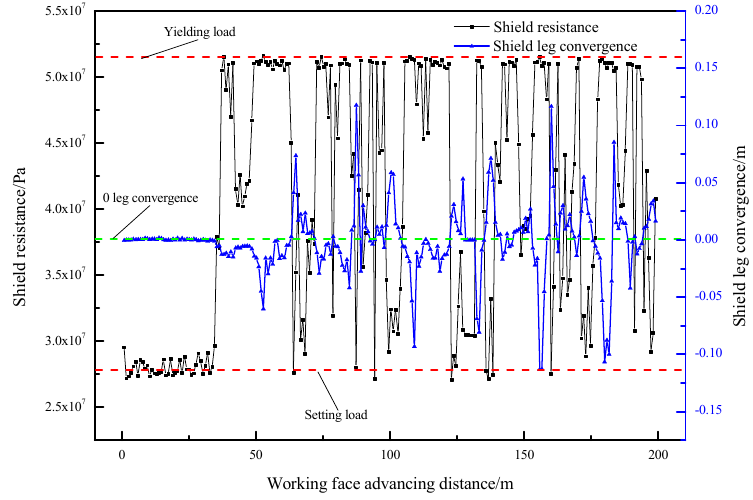
Figure 10. Changes of shield resistance and leg convergence under 6.0 m mining height. For a 6.5 m mining height, the maximum shield resistance reached the yield load 52.8 MPa, the average resistance of the shield was 40.5 MPa, and the single maximum shrinkage of the shield column was 187.0 mm. The first weighting interval of the basic roof was 37.2 m, the periodic weighting interval of the basic roof was 9.5–10.5 m, and the average periodic weighting interval was about 10.0 m, as shown in Figure 11.